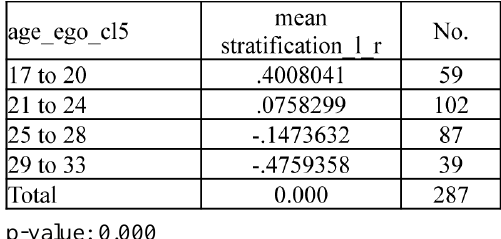
Fig. 16. Distribution of the number of stages